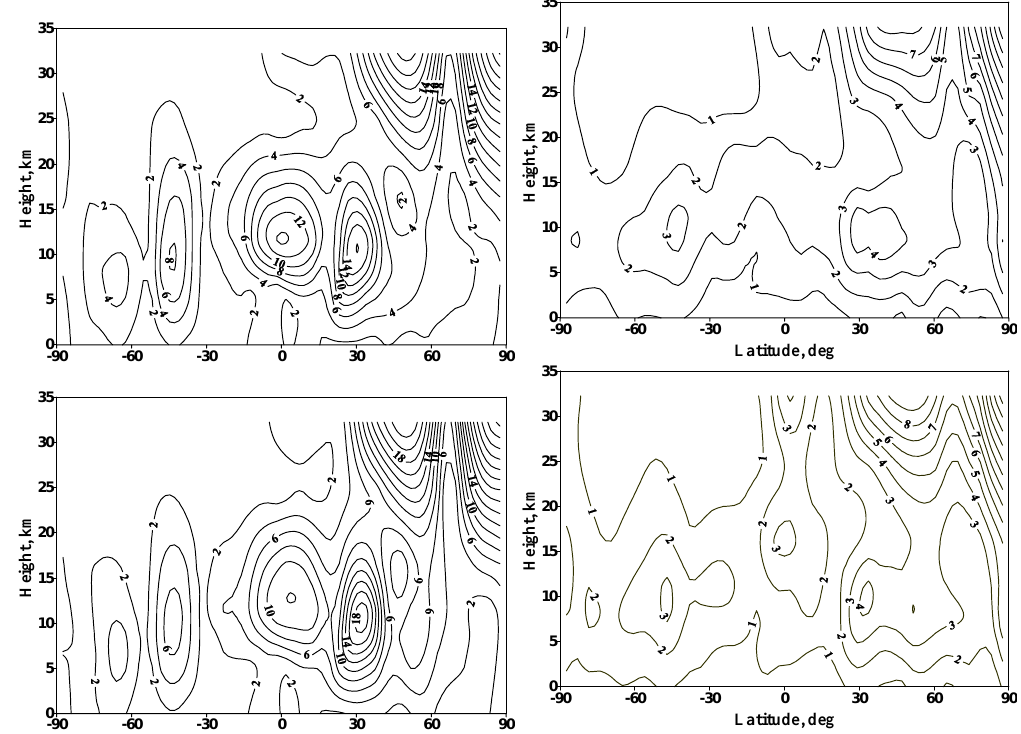
Fig. 9. Amplitudes of SPW1 in zonal wind averaged over January 1959–1980 (left upper panel) and over January 1981-2002 (right upper panel). Contour interval is 2m/s. Lower panels show root-mean-square variability of SPW1 amplitudes, m/s, respectively.